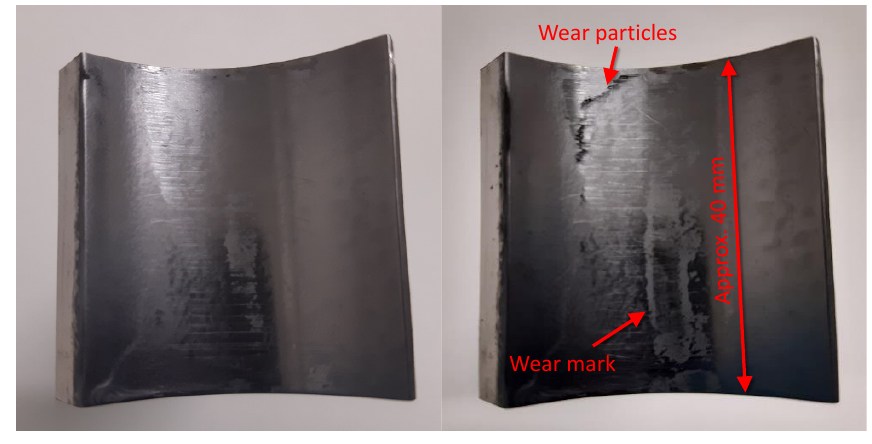
Figure 7. Temperatures and the order of the examinations.